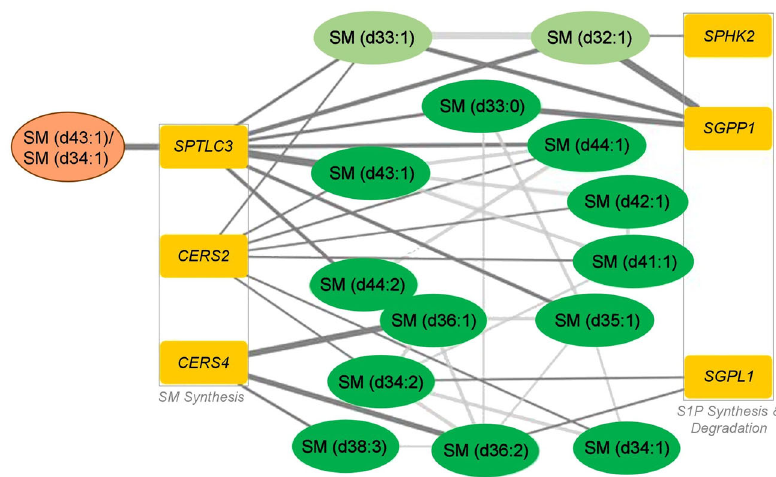
Fig. 4 Hybrid network of genetic associations revealed by gene-based association studies and signi fi cant partial correlations of detected sphingomyelins 9, 20 . The six identi fi ed genes can be grouped into two categories: global sphingomyelin synthesis and synthesis and degradation of sphingosine-1-phosphate. The selected SM ratio is colored orange, other SM species are in green (light green: non-targeted metabolomics in Shin et al. 9 ; dark green: targeted metabolomics in ADNI and Draisma et al. 7 ), and genes are in dark yellow. S1P Sphingosine-1-phosphate, SM sphingomyelin